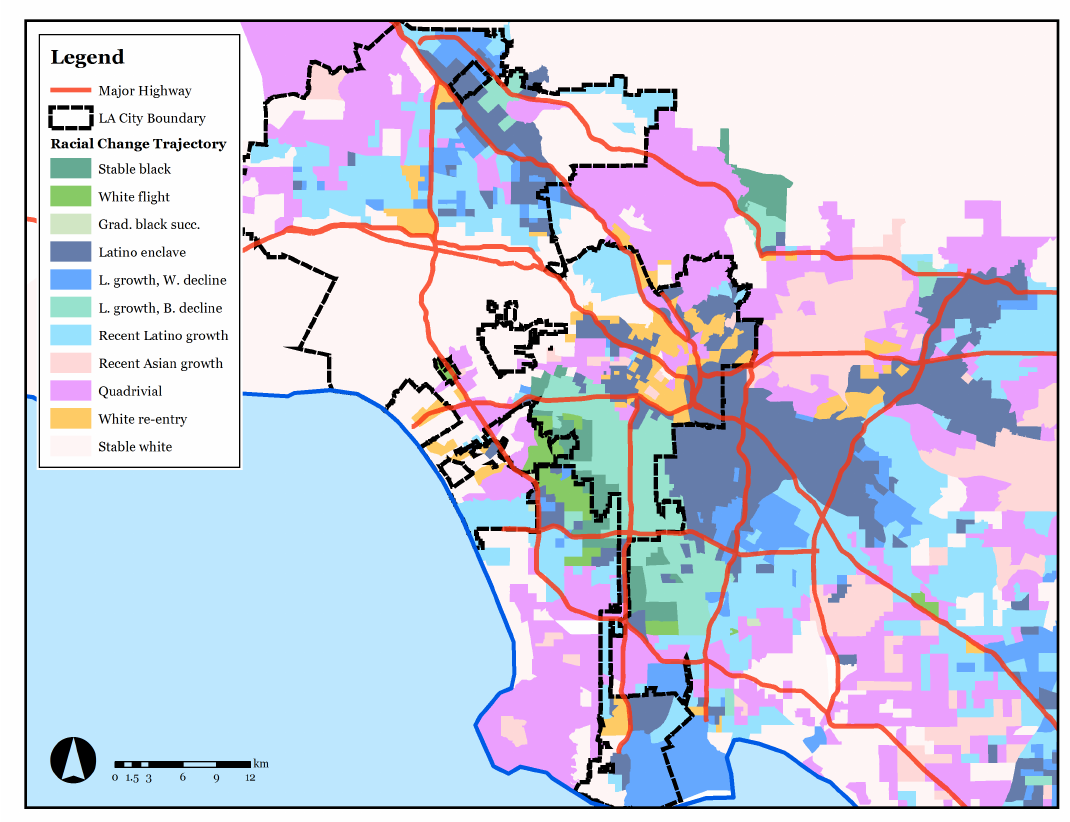
Figure 4: Map of neighborhood racial change trajectories from 1970–2010 in the Los Angeles metropolitan area (map shows a detail of neighborhoods in and near the city of Los Angeles; a map of the complete CMSA is available upon